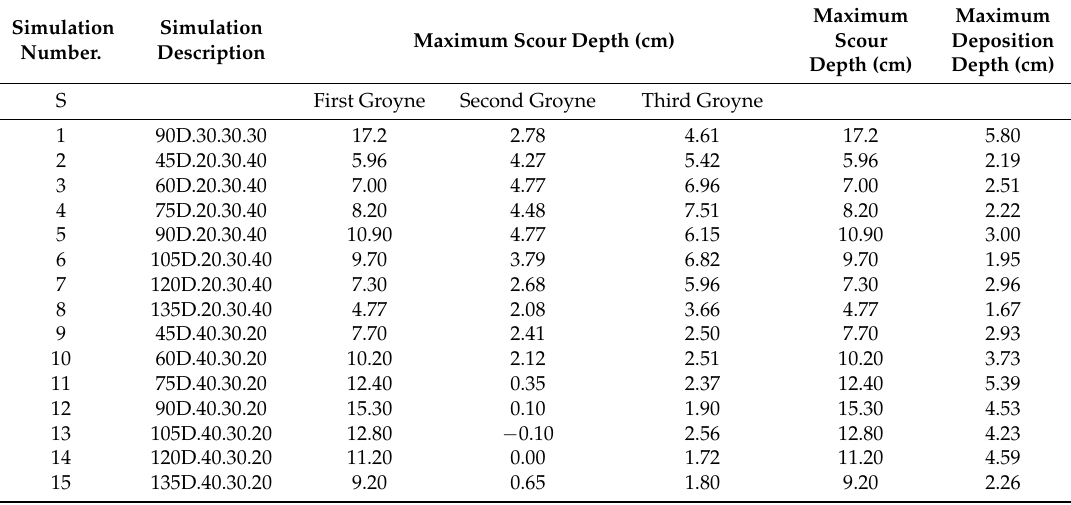
Table 6. Scouring results from the simulation 1/15.